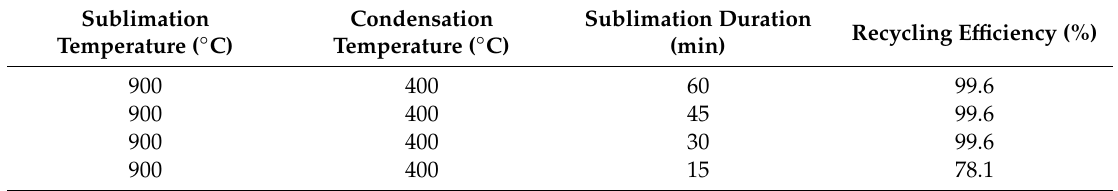
Table 2. Recycling efficiency of the Mo-based catalysts for different sublimation durations.